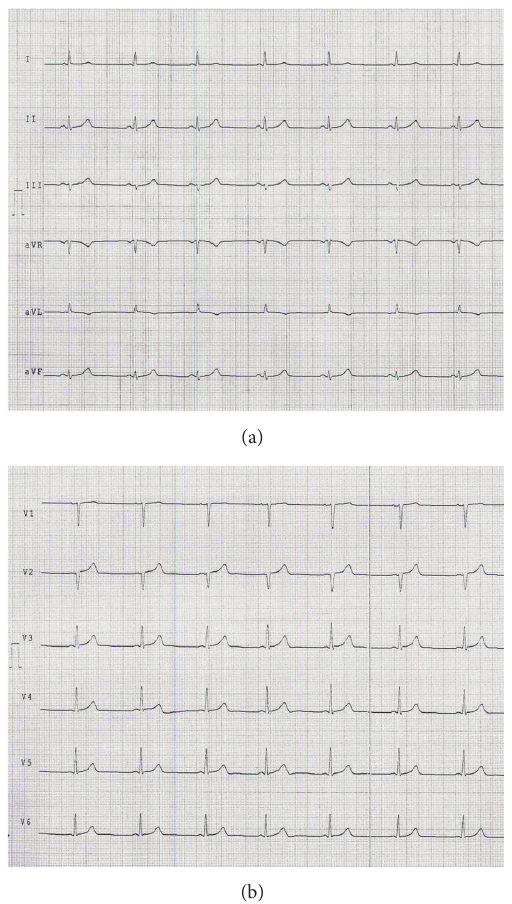
Figure 1: Electrocardiogram at admission showing nonsignificant, ascending ST-elevation in right precordial limbs, with no evidence of mirror images. Also note the negative T wave in aVL.